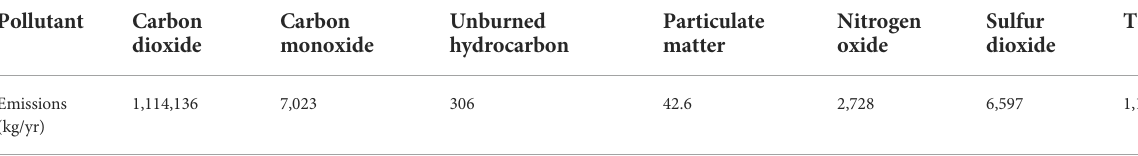
TABLE 5 Annual GHG emission for the stand-alone diesel system.